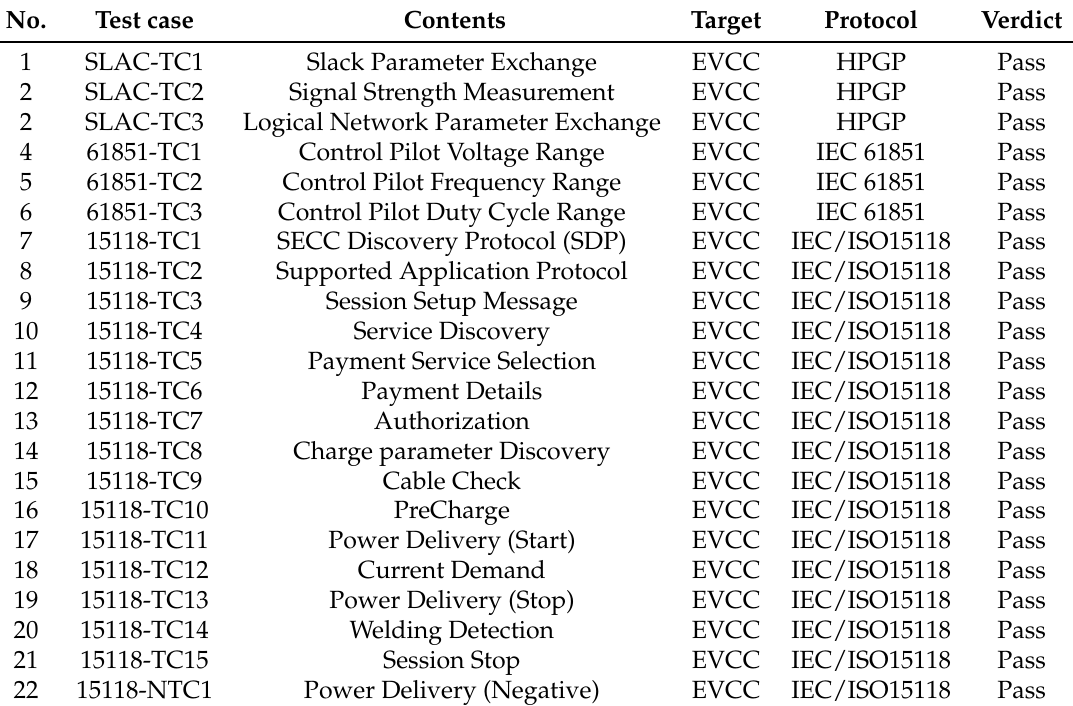
Table 3. Test result of the reference charger with the full ISO/IEC 15118